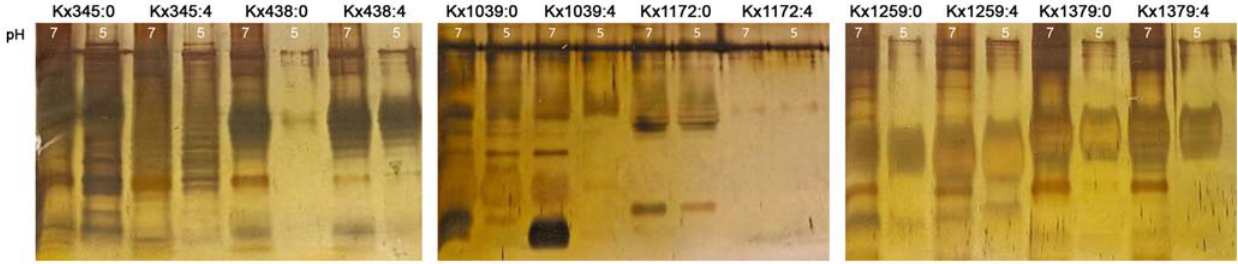
Figure 5. LPS profiles of clinical H.pylori isolates grown invitro at pH 7 and pH 5. Silver staining of LPS from clinical H. pylori single-colony isolates grown in vitro at pH 7 and pH 5, revealed that some of the isolates grown at pH 5 expressed less LPS than isolates grown at pH 7, e.g. isolates Kx1259 and Kx1379 obtained from normal individuals. These isolates presented LPS that lack some of the high- and low-molecular structures in the pH 5 samples as compared to isolates grown at pH 7. The atrophy-associated isolates Kx345, Kx438, Kx1039 and Kx1172 presented similar LPS profiles after growth at pH 7 and pH 5, except Kx438:0 and Kx1039:4, which showed weaker LPS expression at pH 5 as compared to pH 7.